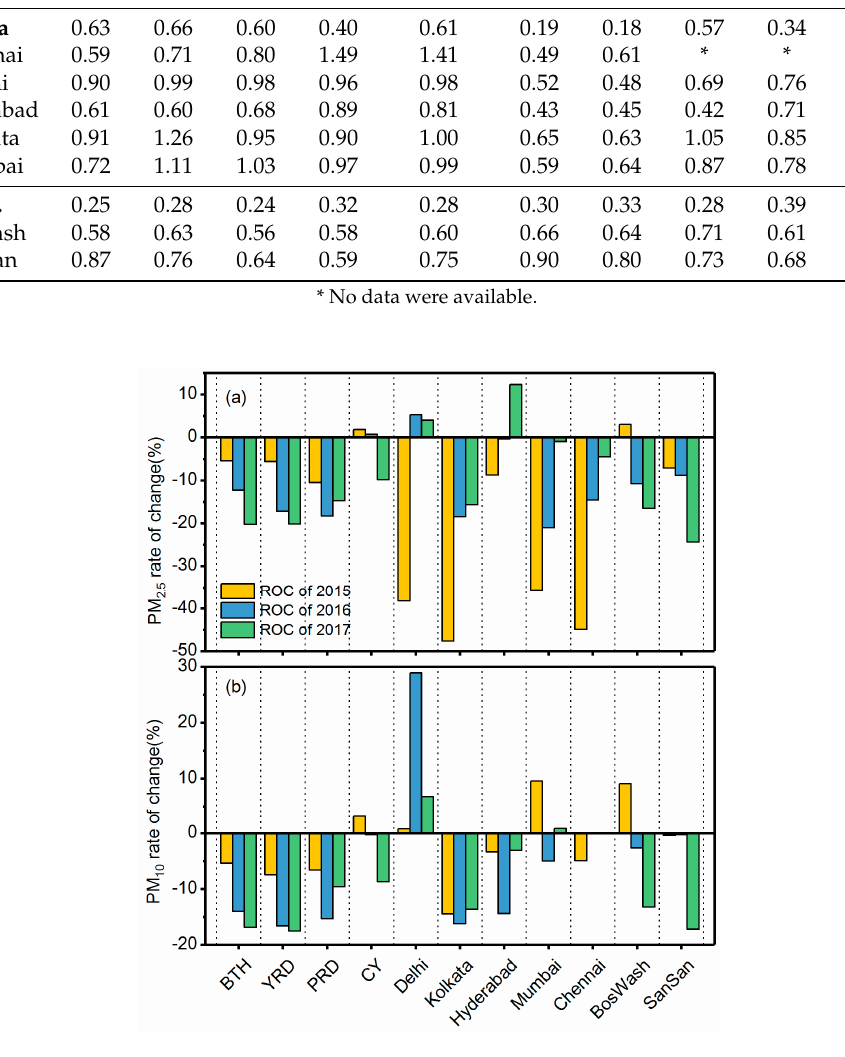
Figure 7. Rate of change for ( a ) PM 2.5 and ( b ) PM 10 from 2014 through the subsequent three years for 11 megacity regions in China, India, and the U.S.